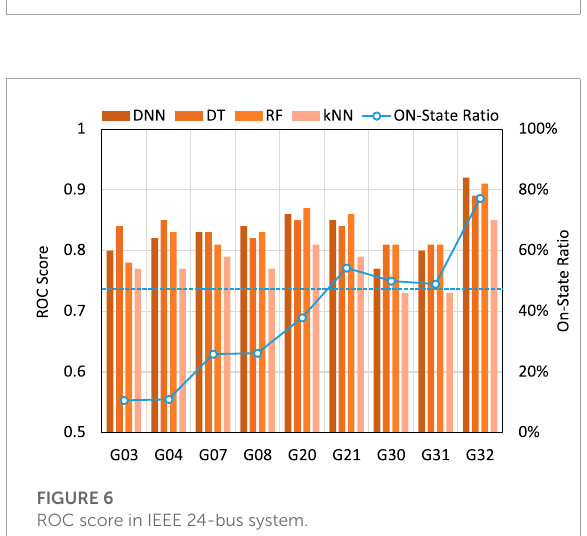
FIGURE 5 Accuracy in IEEE 24-bus system.